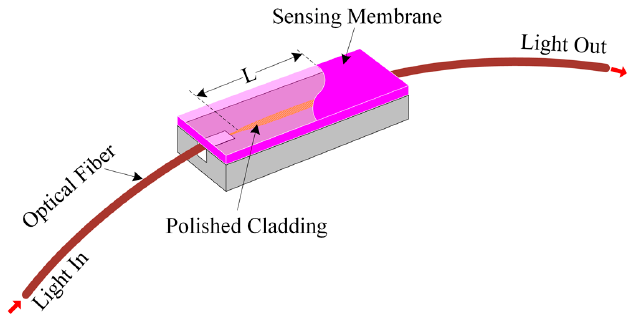
Figure 1. Schematic diagram of the side-polished optical-fiber with a sensing membrane.